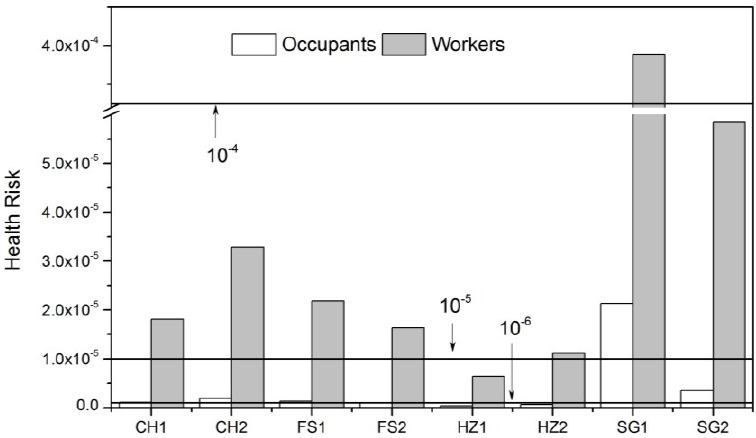
Figure 3. Cancer risk of benzene in indoor air of four spring hotels.